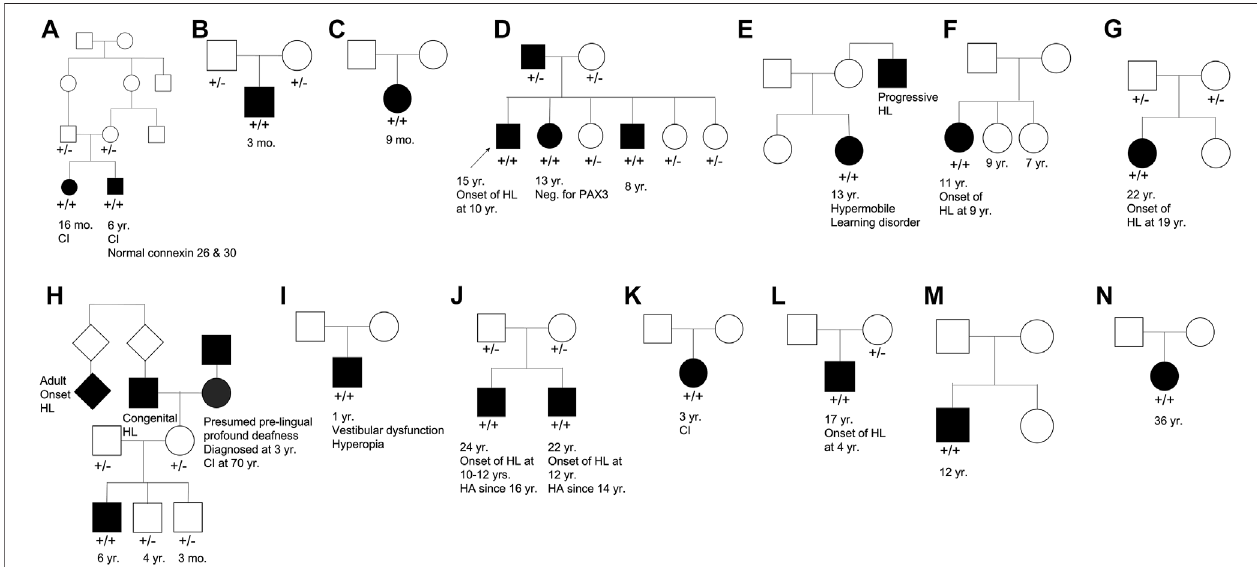
FIGURE2| Pedigreechartforenrolledpatientfamilies (A – N) .Ageatgenetictesting,ageatonsetofhearingloss,andotherrelevantclinicalinformationisprovided, when available, for patients and family members. CI, cochlear implant; HL, hearing loss; HA, hearing aid.